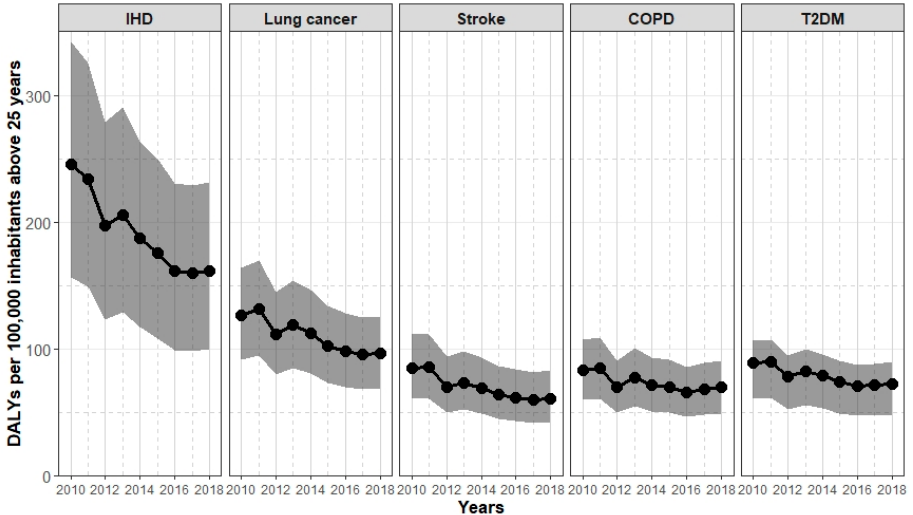
Figure 3. Burden of disease (DALYs per 100,000 people above 25 years including 95% UI) from 2010 to 2018.